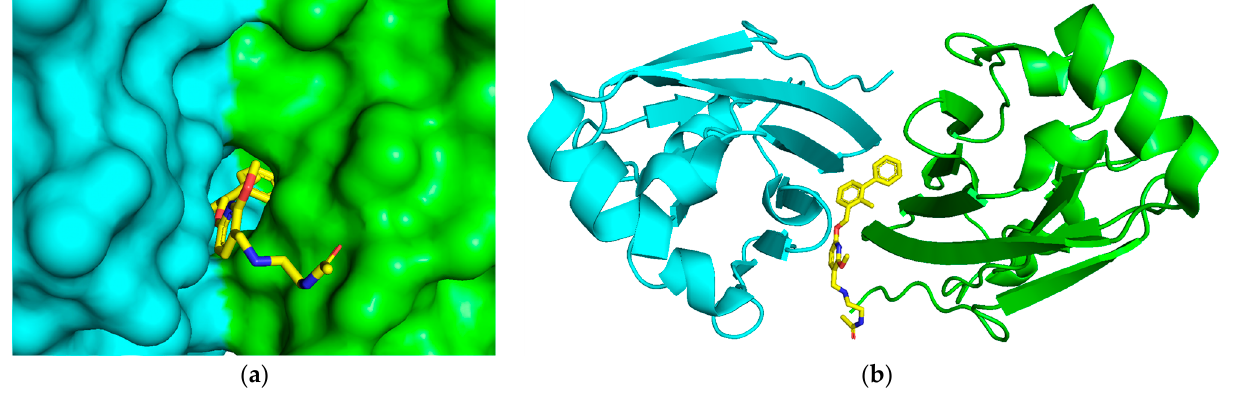
Figure 2. The binding pocket of the PD-L1 dimer/BMS-202 inhibitor crystal structure (PDB code: 5J89). BMS-202 was located at the interface of two PD-L1 chains, and the arrangement of the PD-L1 dimer is nearly axisymmetric. ( a ) Front view. ( b ) Top view. The native crystal conformations of BMS-202 are colored in yellow. Two monomers in PD-L1 dimer are annotated as A PD-L1 and B PD-L1 and colored in green and cyan, respectively.